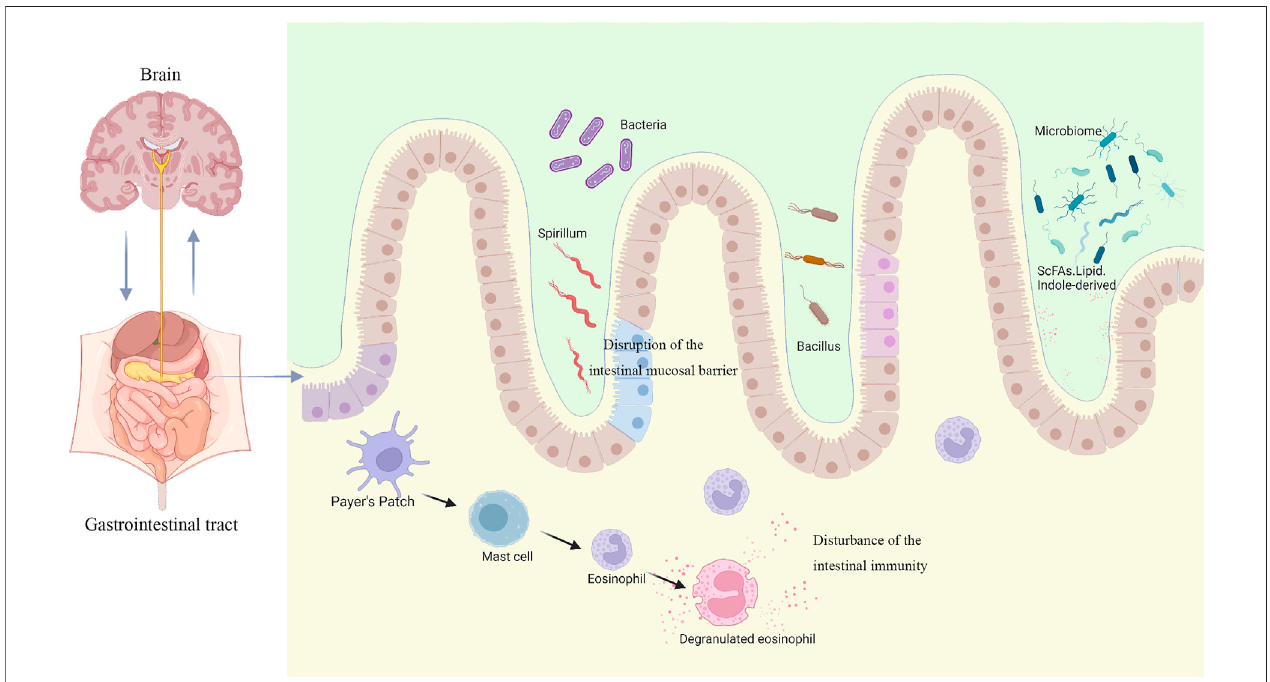
FIGURE 1 | Disease models for the pathogenesis of FD associated with gastrointestinal microbiota (created with BioRender.com).